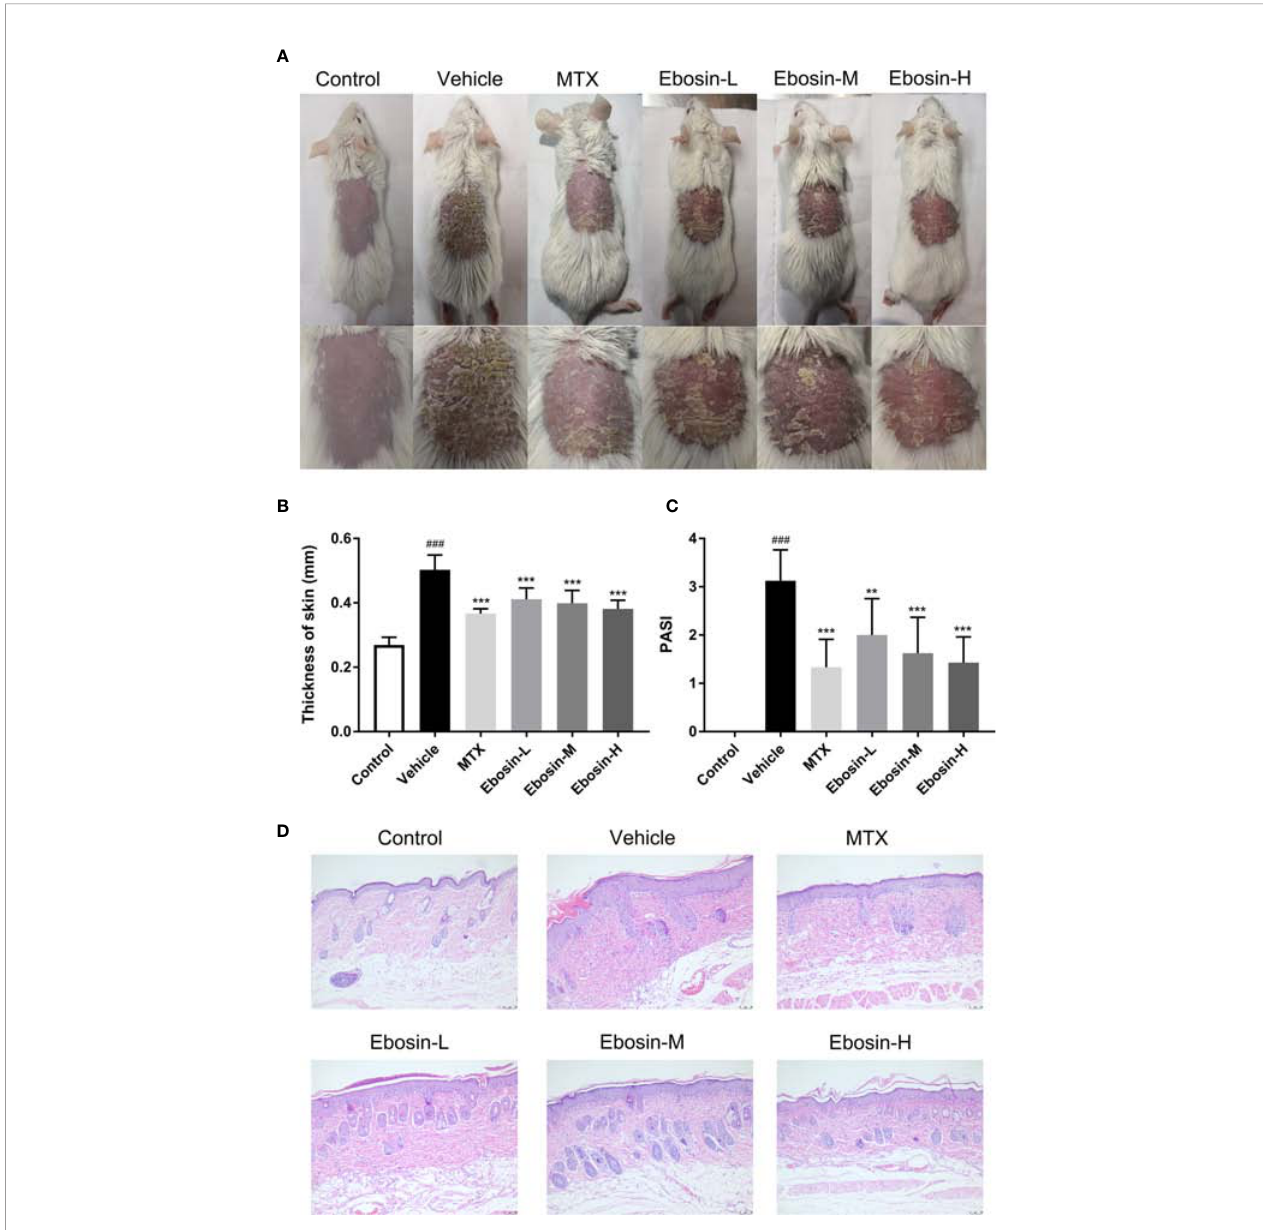
FIGURE 2 | Ebosin ameliorates skin lesion in IMQ-induced psoriatic mice. (A) The representatives of photos of dorsal skin in IMQ-induced psoriasis-like mice 7 days after IMQ-treatment without or with Ebosin. (B) The thickness of dorsal skin (mean ± SD, n = 6). (C) The PASI scores of the skin lesion in IMQ-induced psoriasis-like mice (mean ± SD, n = 6). (D) H&E staining of the skin of control or IMQ-induced psoriasis-like mice after treatment without or with Ebosin (scale bar is 50 m m). ### P < 0.001 vs. control; ** P < 0.01, ***P < 0.001 vs. IMQ-induced vehicle